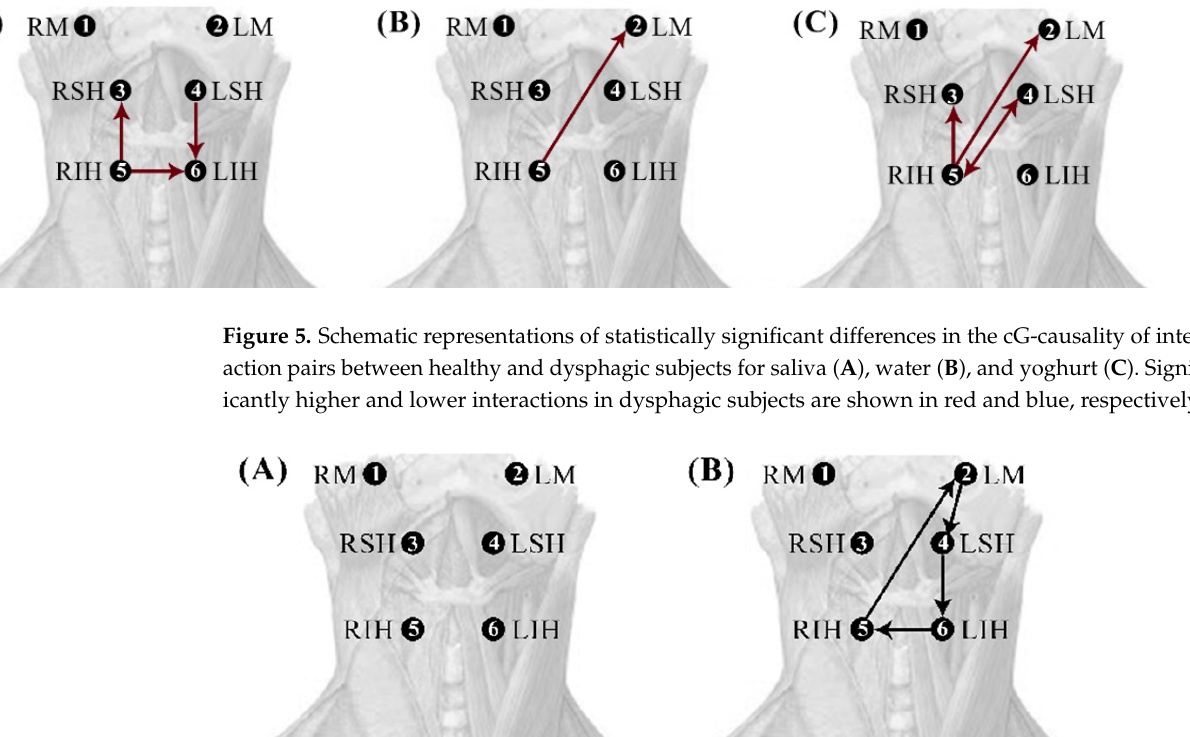
Figure 6. Diagrams with statistically significant differences in the cG-causality of interaction pairs between the different boluses in healthy ( A ) and dysphagic subjects ( B ).